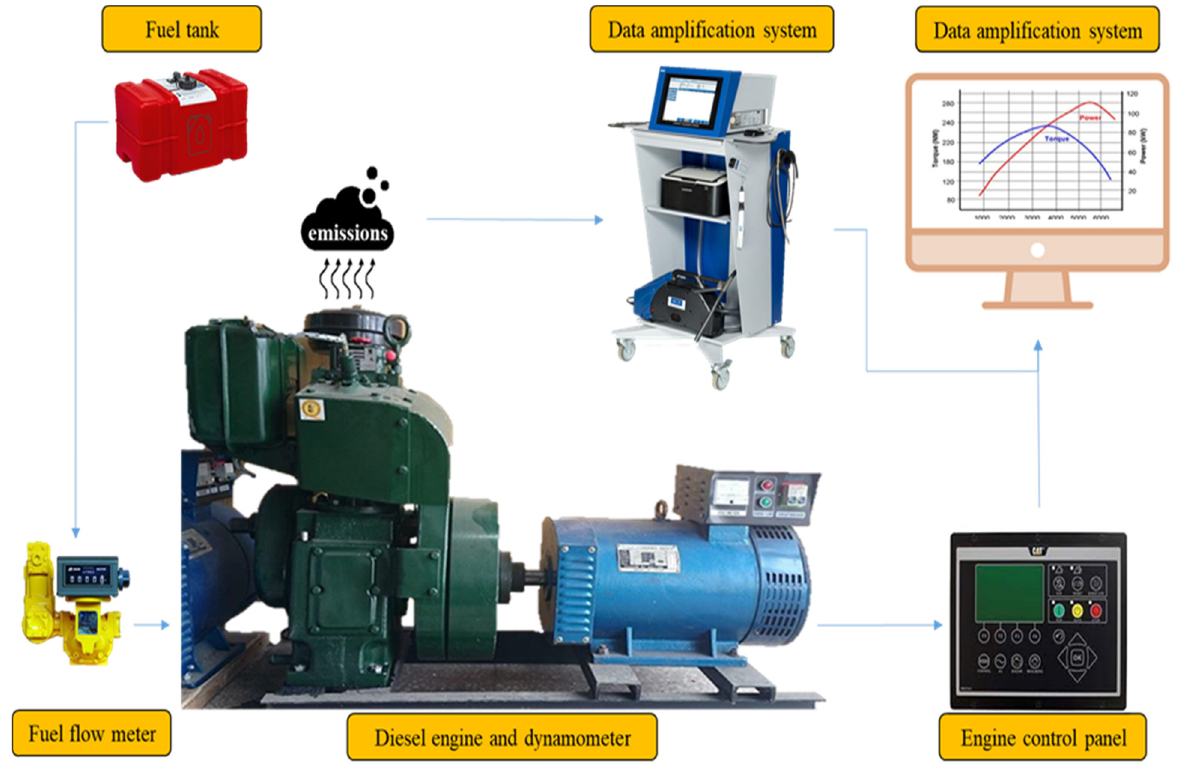
Figure 2: Experimental engine test